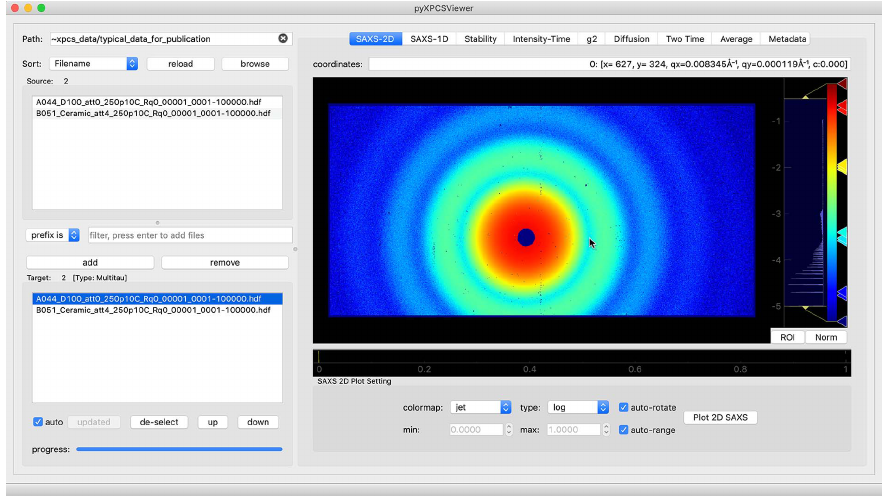
Figure 1 Layout and modules for pyXPCSviewer . In the left panel, users can set or reload the working directory. The data files will be displayed in the source box with the option to be sorted and filtered. Files can be added, removed and sorted in the target box that lists the files for visualization. The right panel contains the visualization modules, organized in tabs — a 2-D scattering pattern is displayed in this